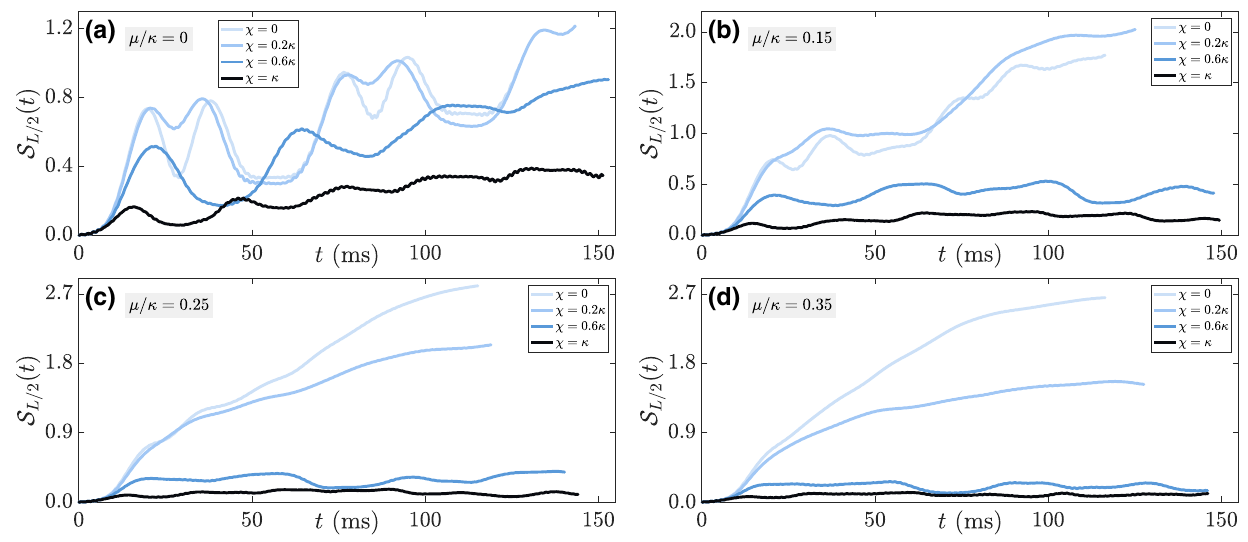
FIG. 7. Same as Fig. 5 but for the bipartite entanglement entropy, which is Eq. (13c) for j = L / 2. (a) In the case of χ/κ = 0, this quench of the vacuum state gives rise to scarred dynamics, which manifest in an anomalously low and slowly growing S L / 2 ( t ) . Nevertheless, upon increasing χ , the bipartite entanglement entropy is suppressed even further, indicating confinement that constrains the dynamics in the quench Hamiltonian’s Hilbert space more than “state-transfer” scarring at χ/κ = 0 does. (b)–(d) For quenches at a finite mass μ/κ > 0, the confined regime shows much more suppressed growth of the bipartite entanglement entropy, where at χ = κ there is almost no growth at late times within the timescales of our numerical